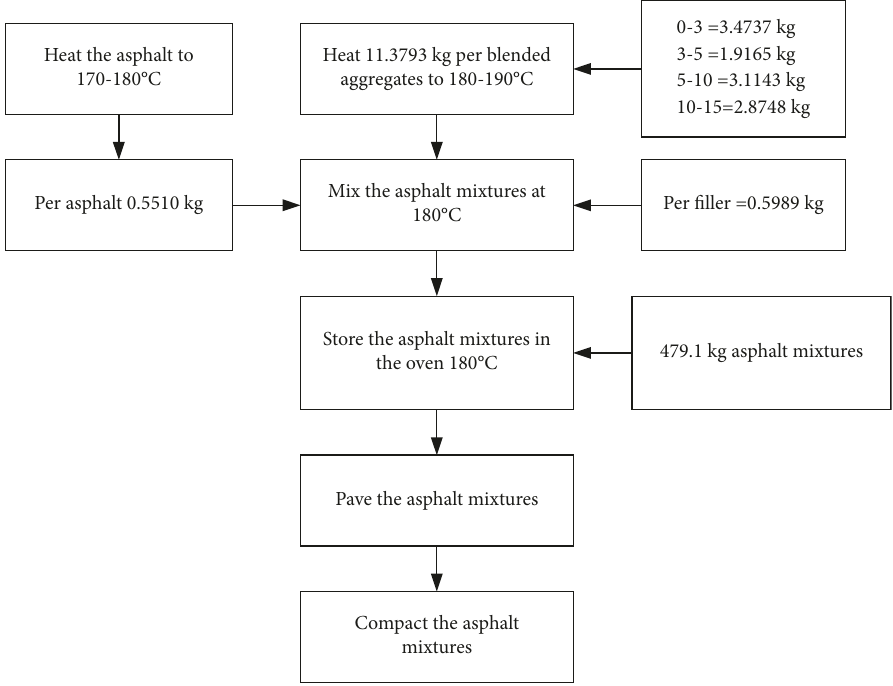
Figure 4: Construction flow chart for the hard sandstone asphalt mixture testing section.